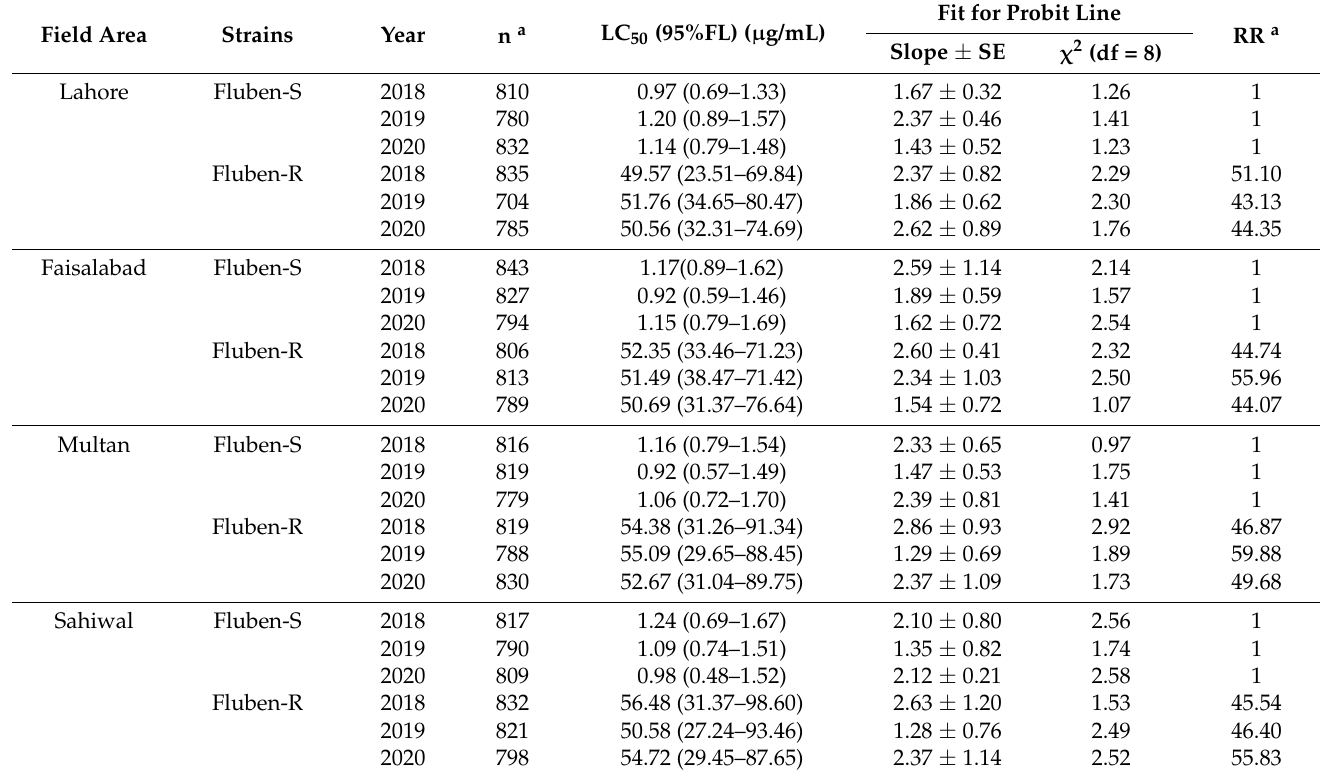
Table 1. Resistance levels of Tuta absoluta field populations to